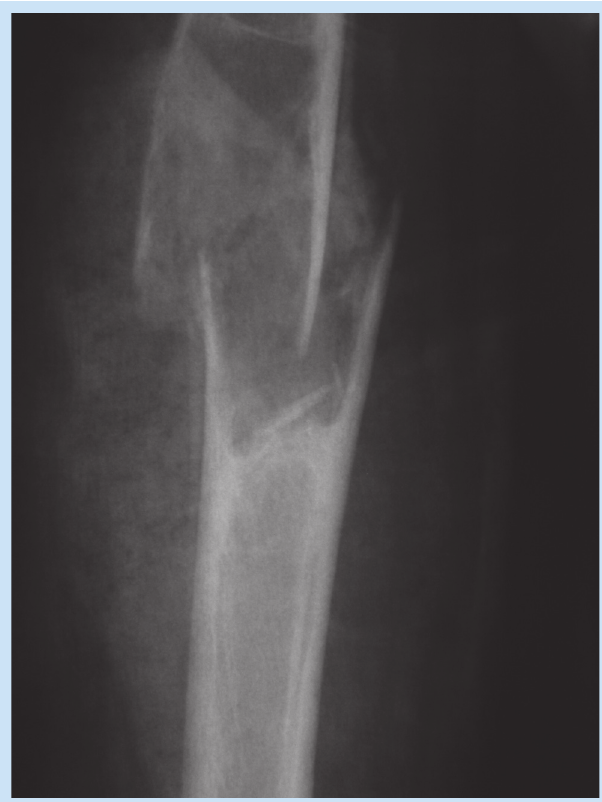
Fig. 3. As the same patient ages, the lesion is seen in the diaphysis, having moved away from the growth plate. This is typical for simple bone cysts.